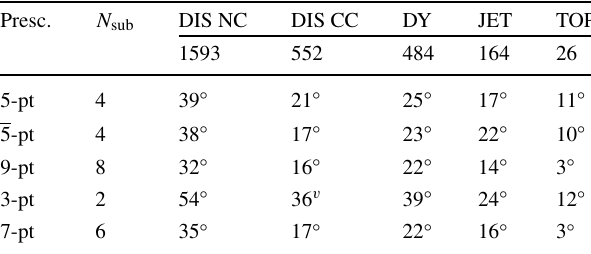
Table 3 The angle θ Eq. (5.7) between this shift and its component δ S lying within the i subspace S (see Fig. 8) spanned by the theory covariance matrix for different prescriptions. The dimension of the subspace S in each case is also given